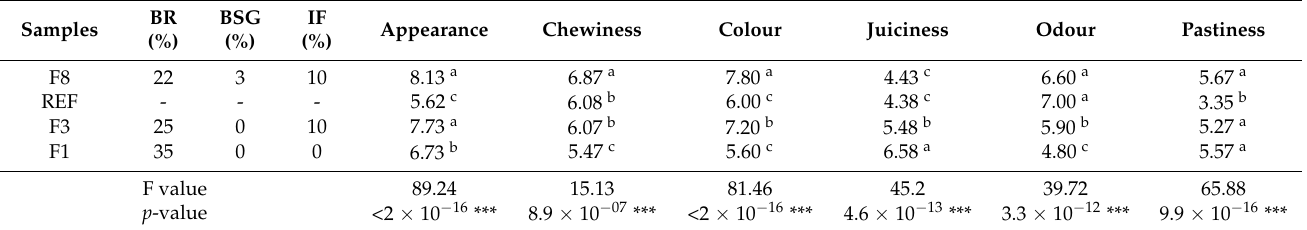
Table 5. Results of the tasting sessions (n = 3) where samples REF, F1, F3 and F8 were assessed. F-value and p -value show the statistics of significance. Significance codes for p -value: ***, (0 < p -value < 0.001). Means with different superscript letters in the same column are significantly different according to Tukey’s test ( p <